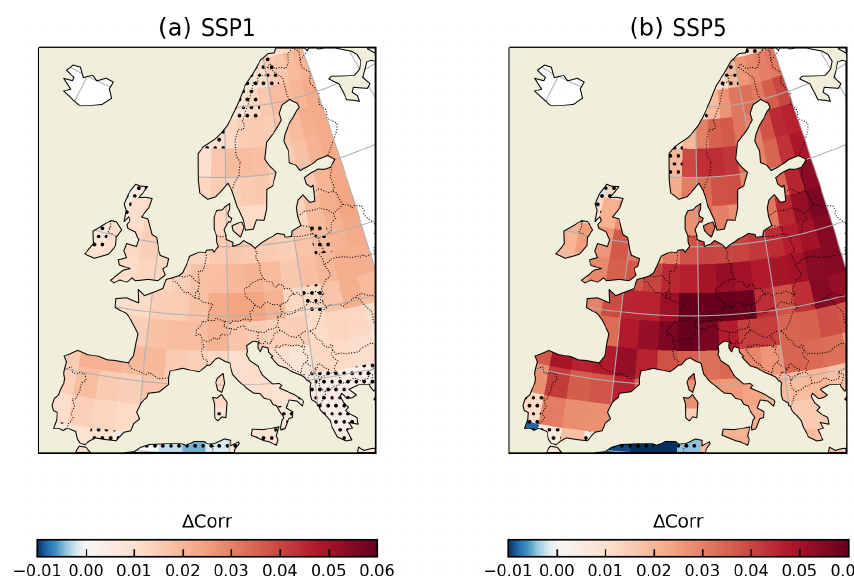
Figure 5. Climate change impacts on daily PV generation correlations in (a) SSP1-2.6 and (b) SSP5-8.5. Changes are computed relative to 1985–2014 and are displayed as the mean across all 28 models. The dots signify less than 75% model agreement in the sign of the projected